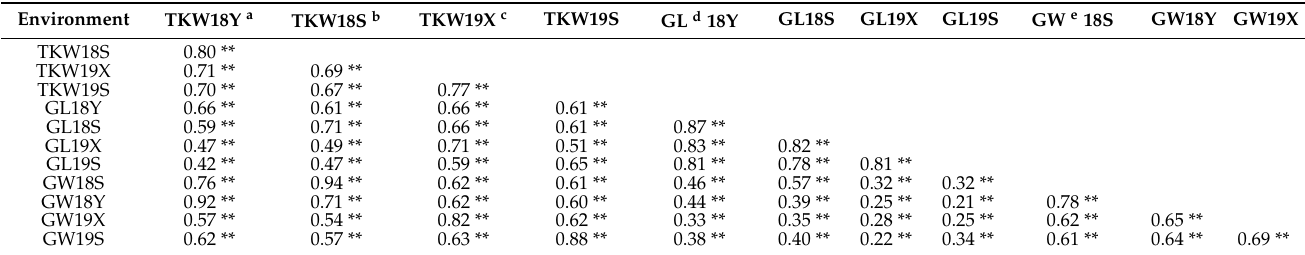
(Table 2), indicating that GL was more insensitive to the environmental variation than TKW and GW in the present study. Table 3. Correlation coefficients among 12 environmental phenotypic data in an F 6 recombinant inbred lines (RILs) population derived from a cross of HN5290 ×